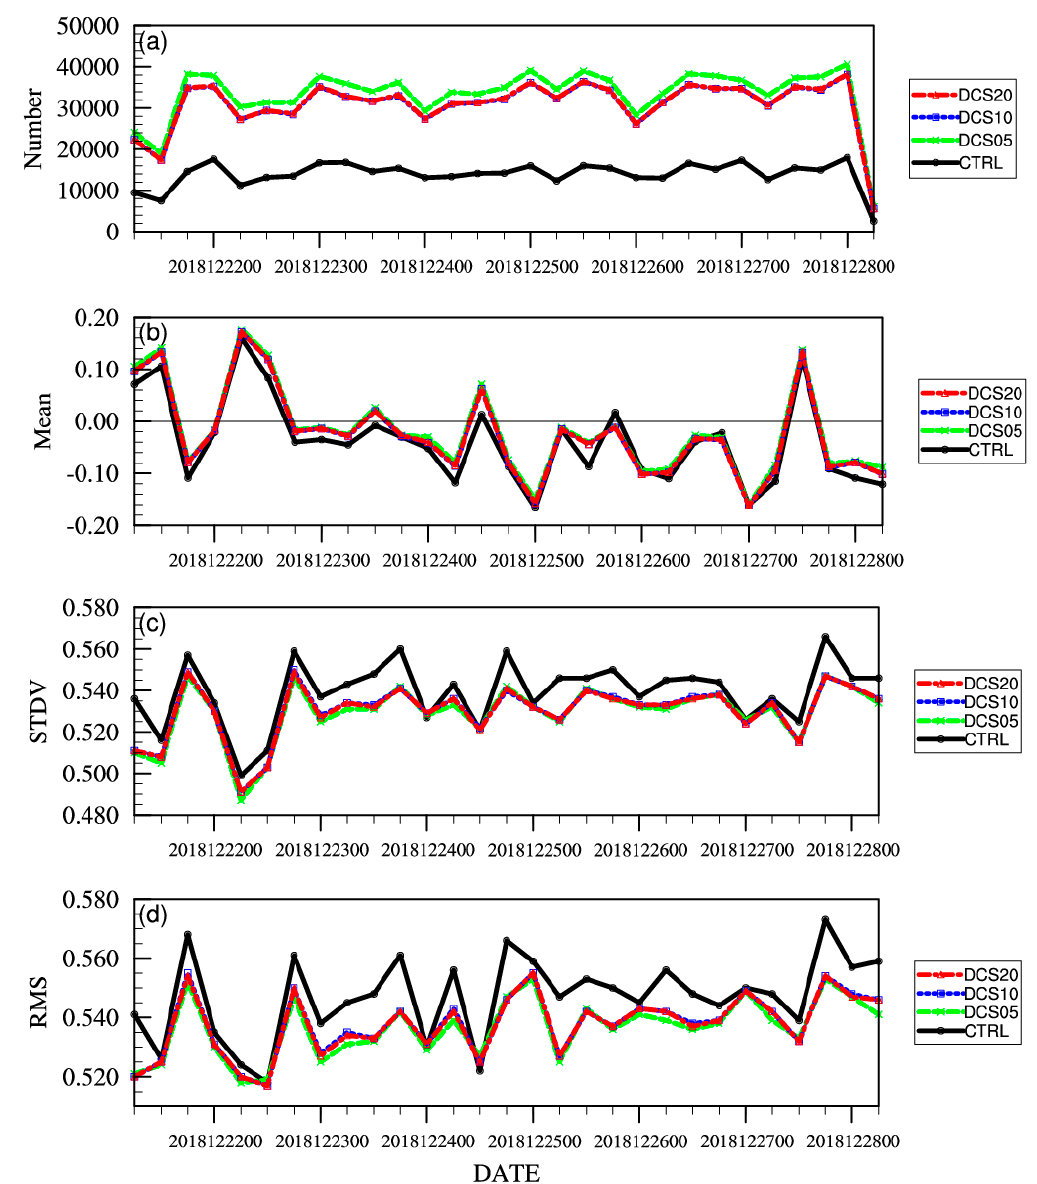
Figure 11. The (a) the number of observations, and (b) mean, (c) STDV and (d) RMS of the O-B for MWTS-2 channel 5 data obtained between 0600 UTC on December 21 and 0600 UTC on December 28, 2018.